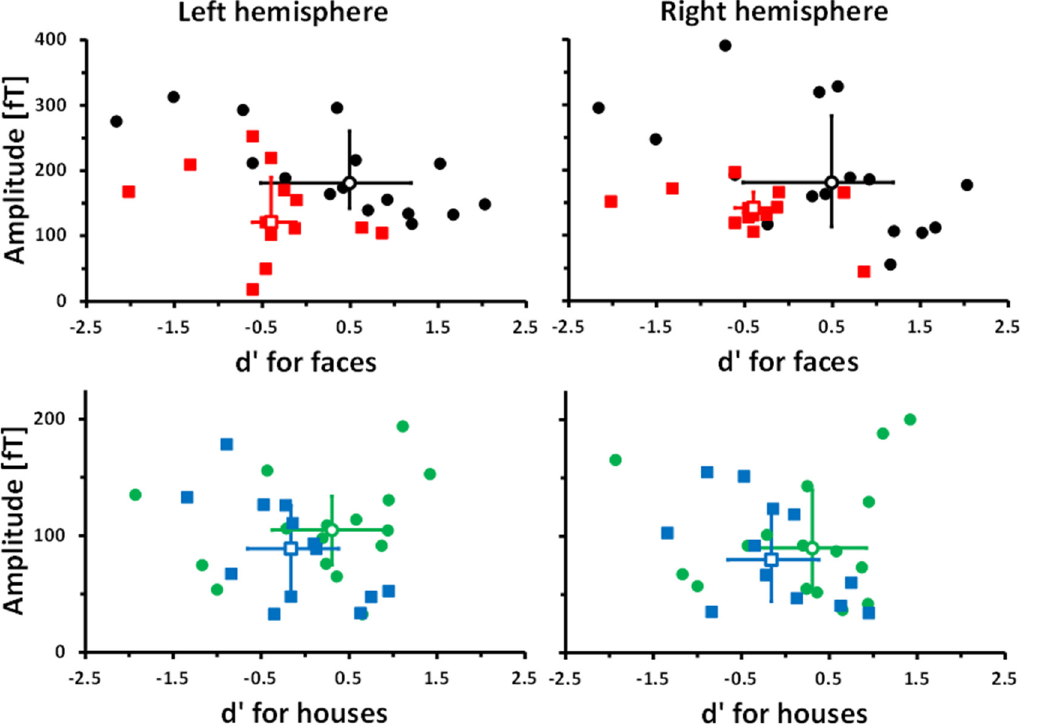
Fig 8. Scatter plots: M170 amplitude versus dprime (d ’ ). For colour coding cf. Fig 2. Table 2 displays the statistics. Open symbols represent medians; error bars show IQR ’ s.